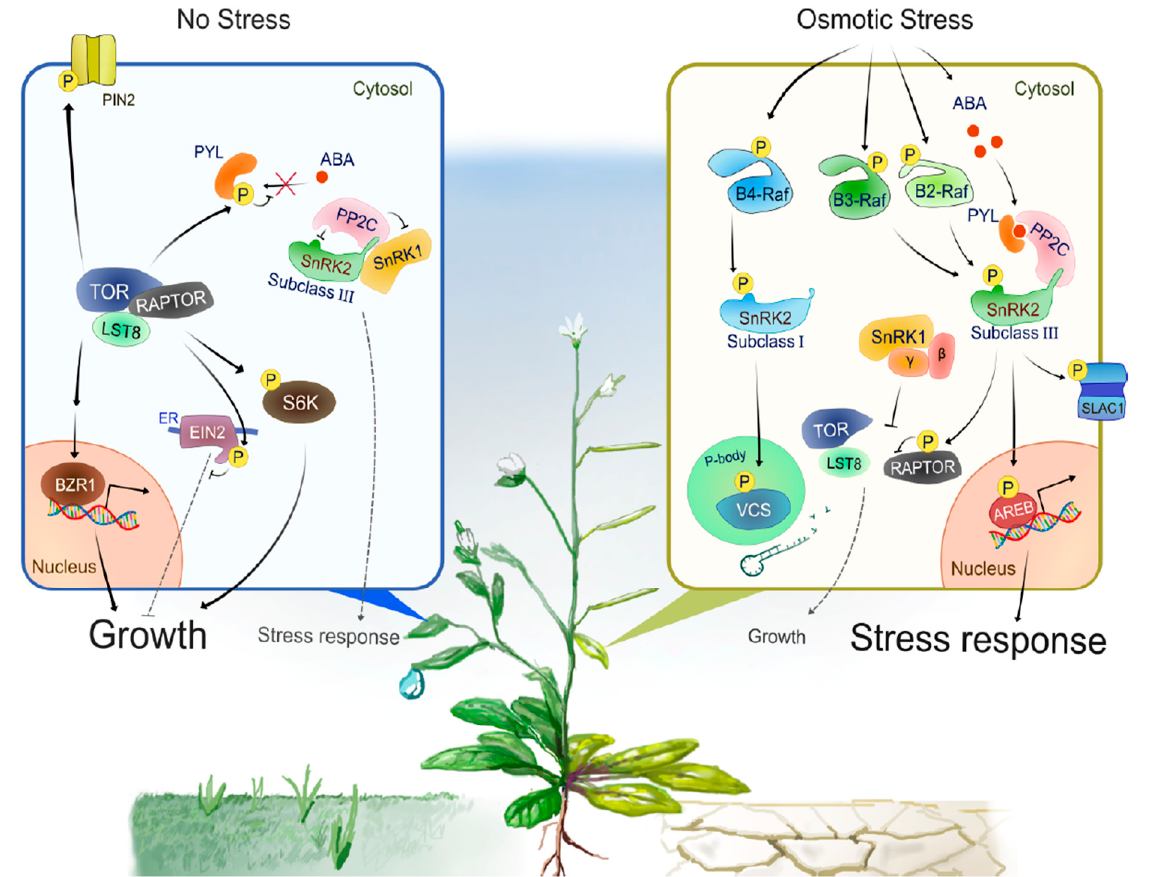
Figure 2. A model of the intracellular signal transduction under optimal growth conditions or during osmotic stress responses.Under optimal growth conditions (No Stress), TOR, RAPTOR and LST8 form a complex and promote cell division, expansion or elongation for plant growth through positive regulation of growth promotion-related factors such as S6K, BZR1 and PIN2. In addition, TOR directly phosphorylates PYLs or EIN2 to negatively regulates stress-associated phytohormone signaling such as ABA and ethylene, respectively. TOR-mediated phosphorylation of PYLs inhibits PYL-binding to ABA, therefore active PP2Cs dephosphorylate and inactivate subclass III SnRK2s to compromise ABA signaling and other protective stress responses. Such a PP2C-SnRK2 complex sequesters SnRK1, thereby allowing TOR activity and growth. Under water-deficit conditions (Osmotic Stress), multiple group B Raf-like protein kinases are rapidly activated. B4 Raf-like protein kinases directly phosphorylate and activate ABA-unresponsive (subclass I) SnRK2s, thereby enhancing mRNA decapping activator VARICOSE (VCS) activity to modulate mRNA population under osmotic stress responses. On the other hand, ABA-responsive (subclass III) SnRK2s activate in the both ABA-dependent and -independent manner. That is, osmotic stress promotes ABA biosynthesis and increased ABA is perceived by PYLs, leading to the formation of PYL-ABA-PP2C complexes, thereby releasing subclass III SnRK2s from inhibition by PP2Cs. In addition, osmostress-activated B2/B3 Raf-like protein kinases directly phosphorylate and activate subclass III SnRK2s. Activated subclass III SnRK2s phosphorylate downstream substrates such as bZIP-type transcription factor AREBs and ion channel SLAC1, to promote ABA responses or other protective stress responses including regulation of stress-responsive gene expression and stomatal closure. SnRK1 is released from the sequestration by PP2C-SnRK2 complex and inhibits TOR-mediated signaling to repress growth. The β and γ represent the regulatory subunits of heterotrimeric SnRK1